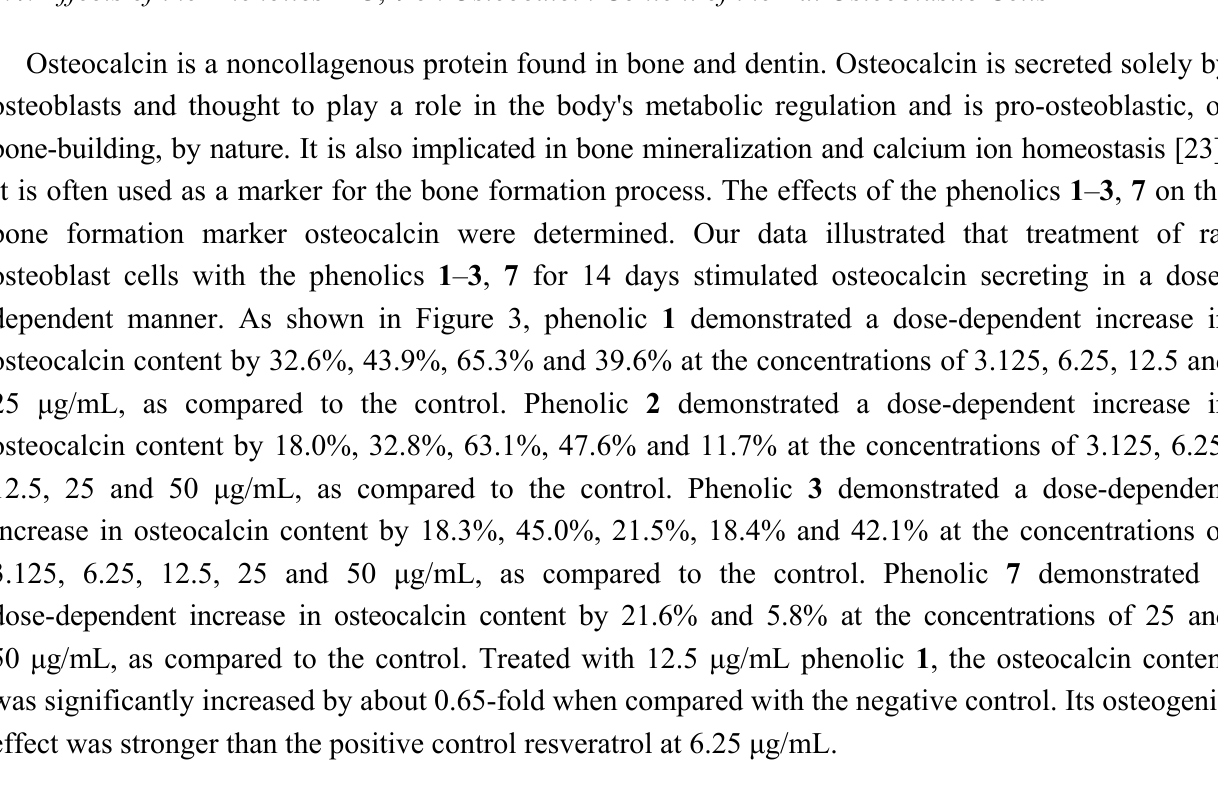
Note: * p ˂ 0.05 vs. negative